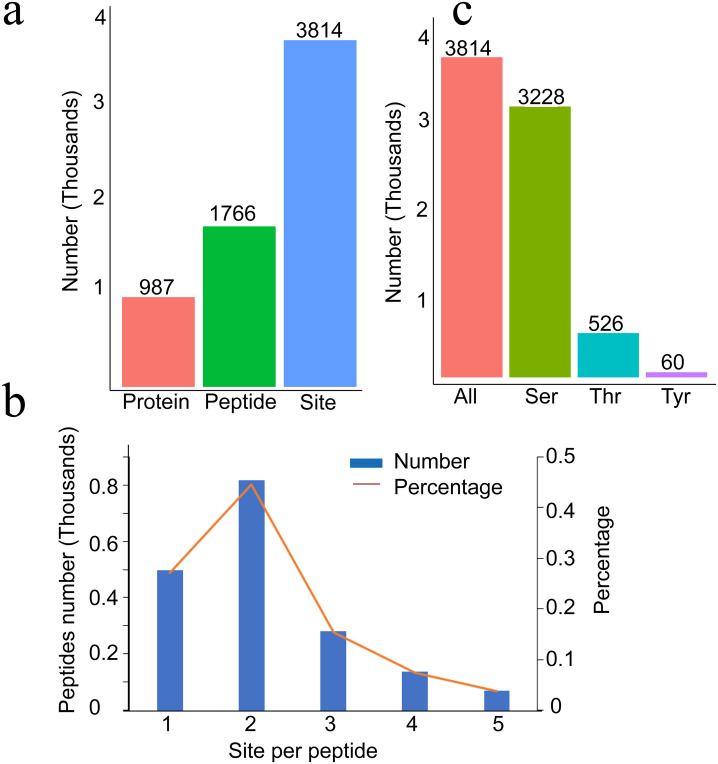
Phosphorylation statistics.(a) Identified phosphoproteins, (b) phosphopeptide site analysis, and (c) patterns of identified phosphorylation sites.